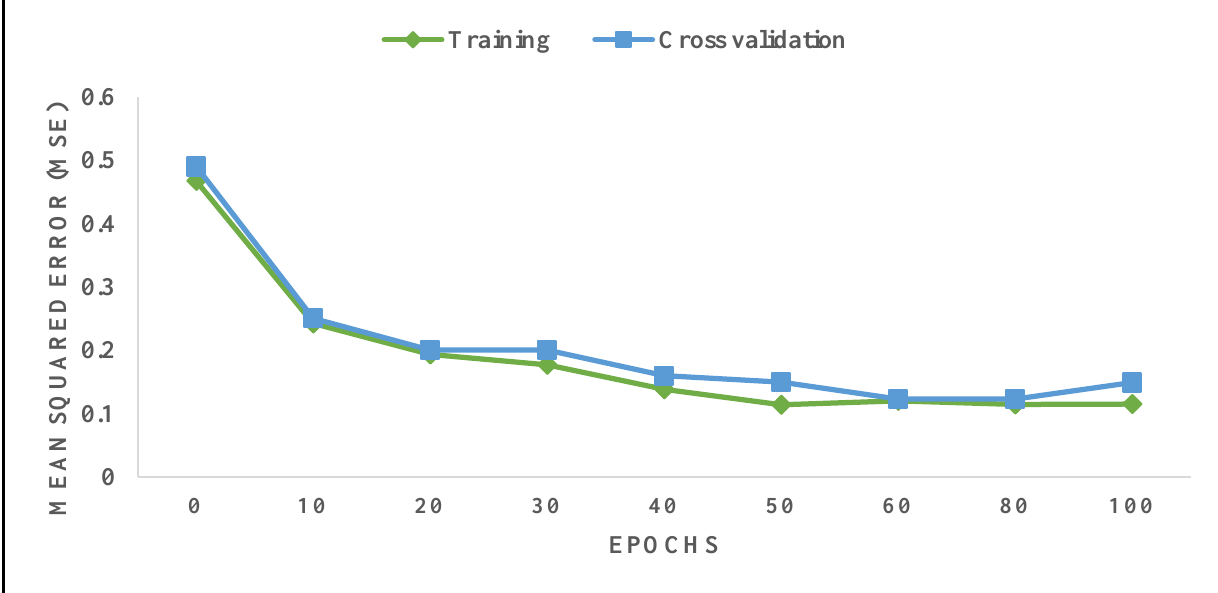
Figure 2. Convergence of the average MSE value during training and cross validation of ANN model.